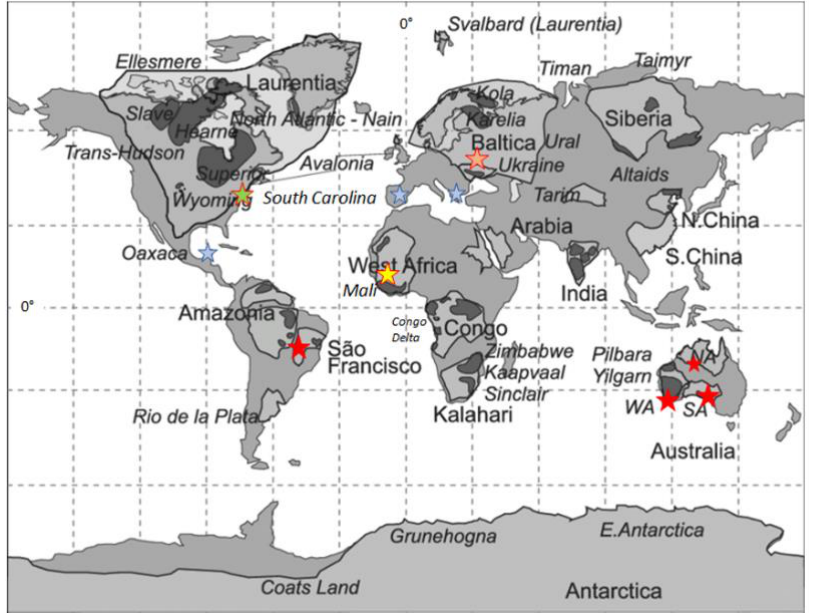
Figure 1. Location of the depressions studied in this paper. Red stars represent the places in Brazil and Australia where new data are presented, for the other locations we have used the published data in yellow Mali [4], in green South Carolina [22] and in orange Russia [8]. The dolines cited in the paper are in blue (Spain, Yucatan and Greece). Map background: Precambrian continents and cratons of the world in their present-day locations. Light gray shading: Proterozoic areas, dark slate gray: Archaean basement, modified from [30].